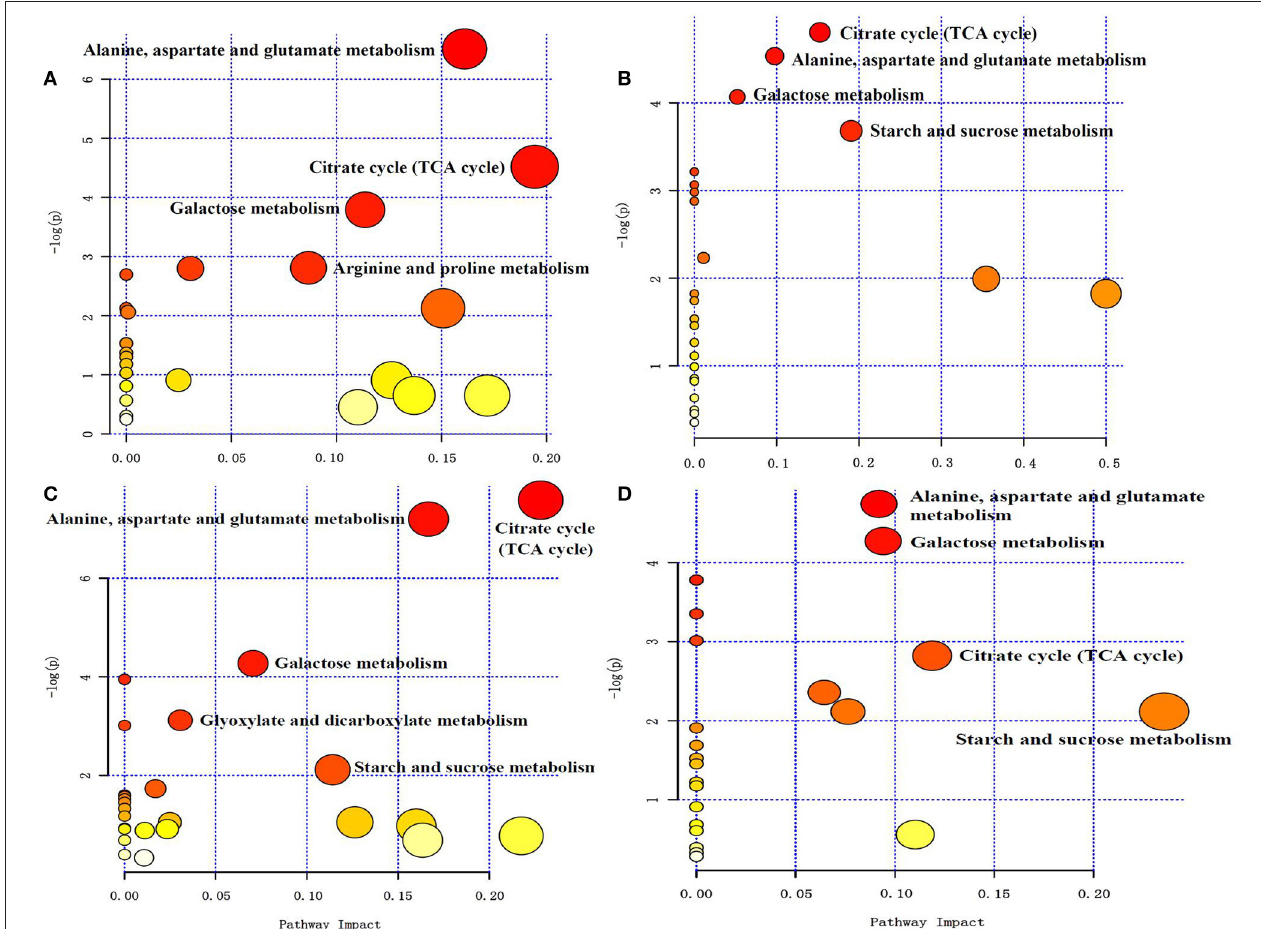
FIGURE 7 | (A) NI Control and NI 6 days after alkali stress pathway enrichment (B) RI Control and RI 6 days after alkali stress pathway enrichment (C) NI Control and RI Control pathway enrichment (D) RI 6 d after alkali stress and NI 6 d after alkali stress. Pathway enrichment, the abscissa pathway impact represents the influencing factor of the path topological analysis, and the ordinate − log (P) represents the P -value of the pathway enrichment analysis (negative logarithm). At the same time, the bubble size indicates the influence factor of topological analysis, the bigger the bubble is, the bigger the impact factor is. The color of the bubbles indicates the P- value (negative logarithm) of the enrichment analysis. The darker the color, the larger the value of − log (P), the more significant the enrichment.